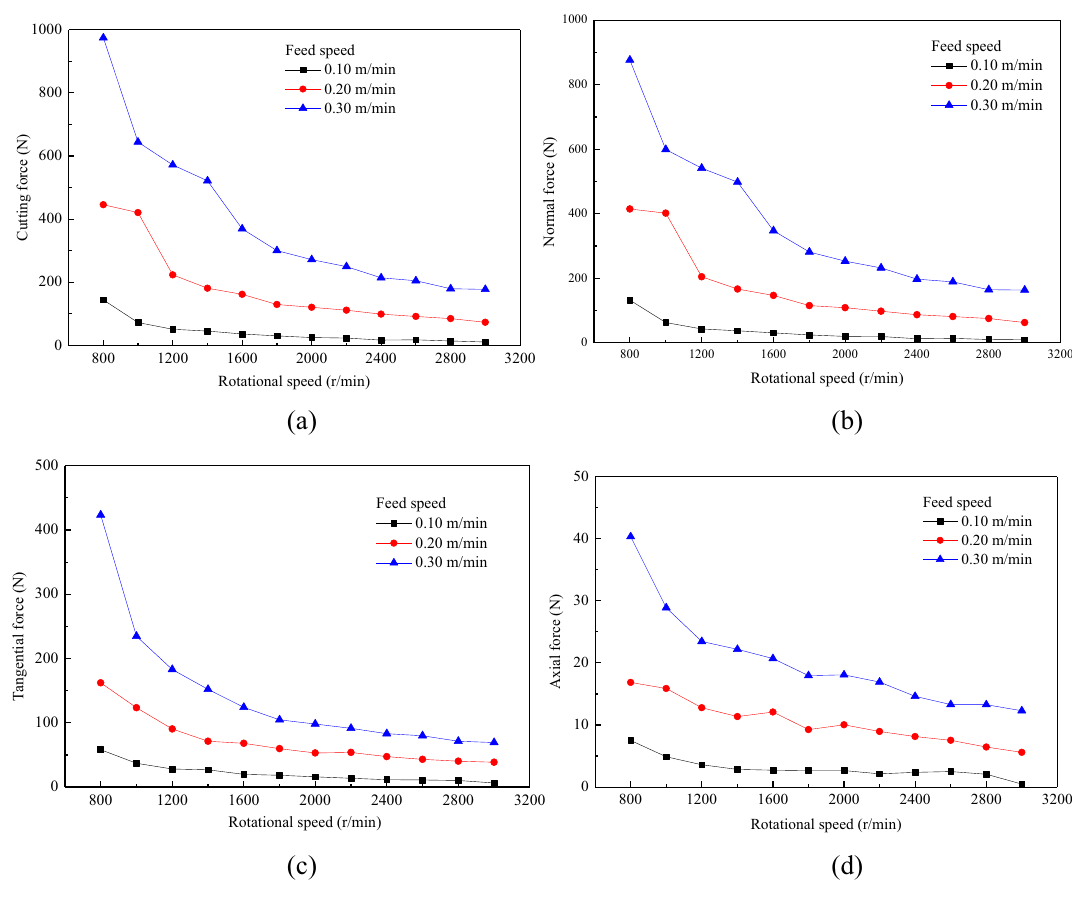
Figure 11. The variation of mean force with rotational speed for different feed